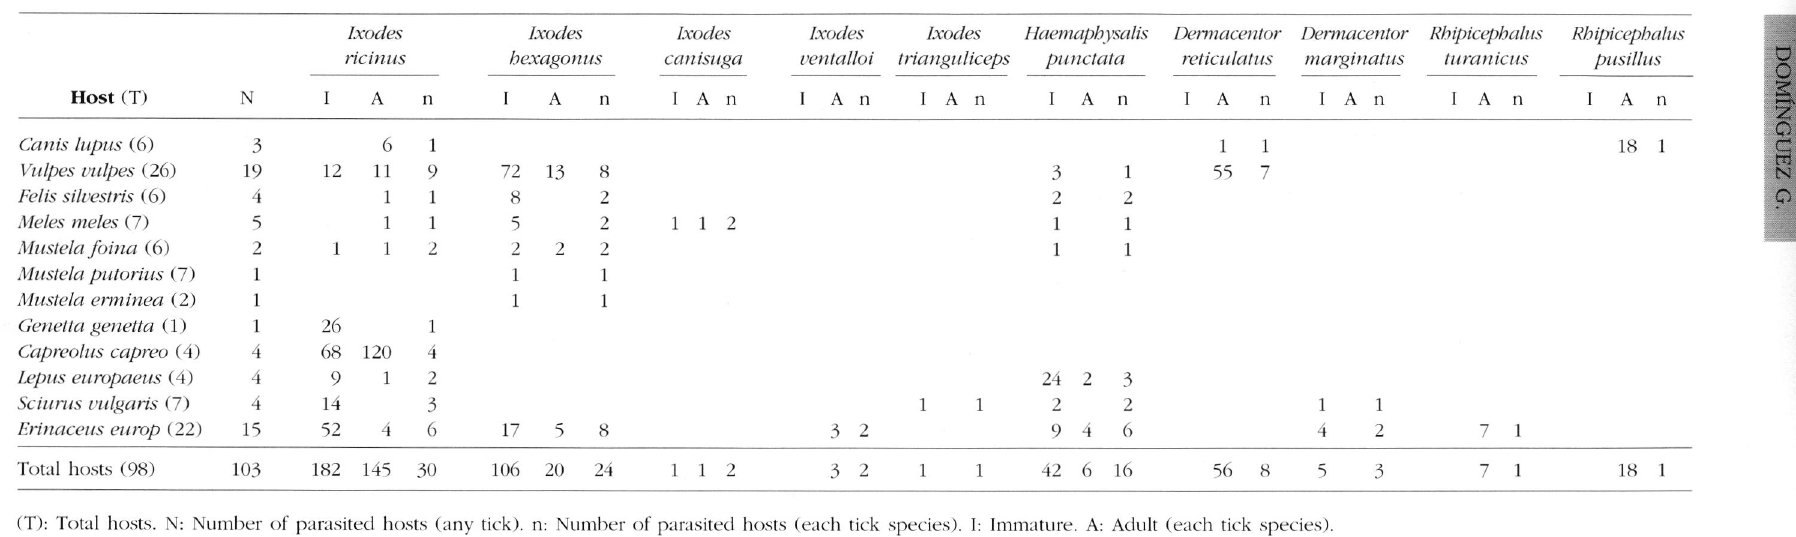
Pa. m. Fu. Ct.f. Ce. 6W.)s. Ob.